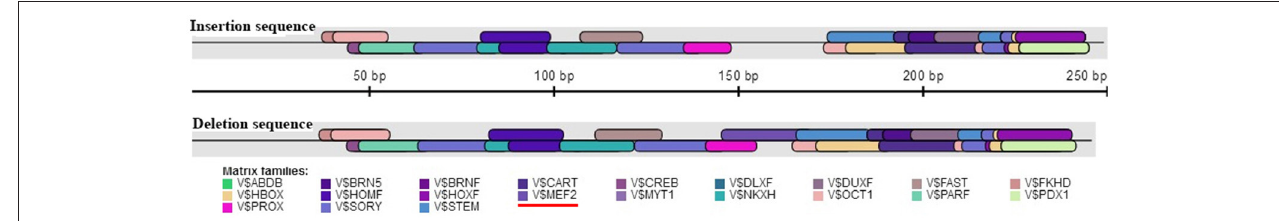
FIGURE 7 | Bioinformatics predict transcription factor binding sites on the 16 bp indel sequences. One potential transcriptional factor MEF2 (myocyte-specific enhancer factor 2) only appear at deletion sequence. Red underline highlights MEF2 factor.